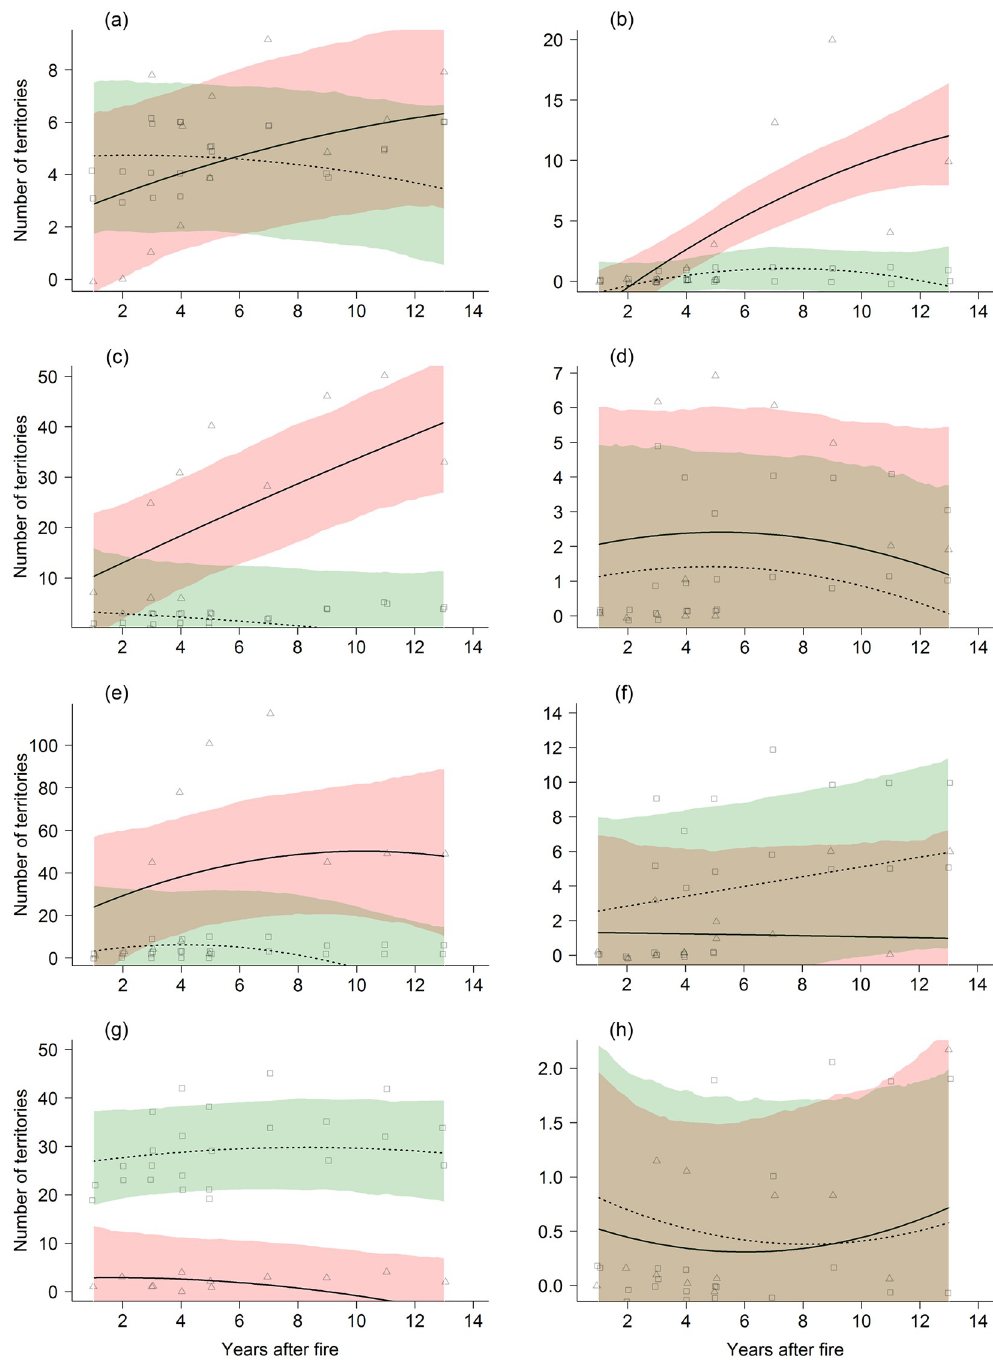
Fig 1. Number of territories in relation to years after fire. Shown are regression lines and 95% confidence intervals for the burnt forest (solid line, red) and control forest (dashed line, green) for Common Cuckoo (a), Eurasian Wryneck (b), Common Redstart (c), Eurasian Linnet (d), Rock Bunting (e), Ring Ouzel (f), Crested Tit (g), and Black Grouse (h).